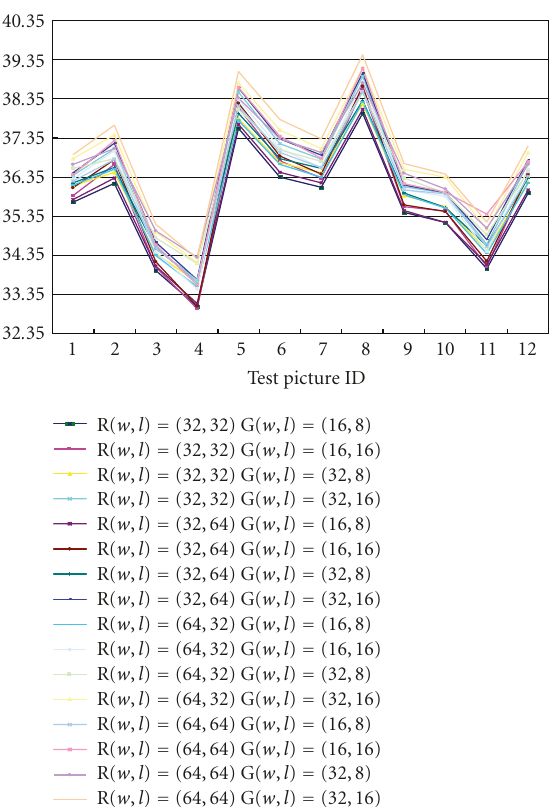
Figure 11: The compression performance of the GICam-II image compressor.